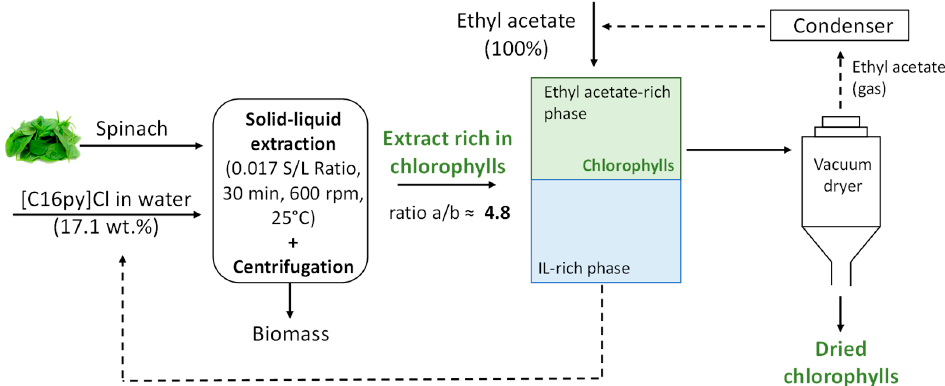
Figure 6. Schematic process of extraction and recovery of chlorophylls developed.